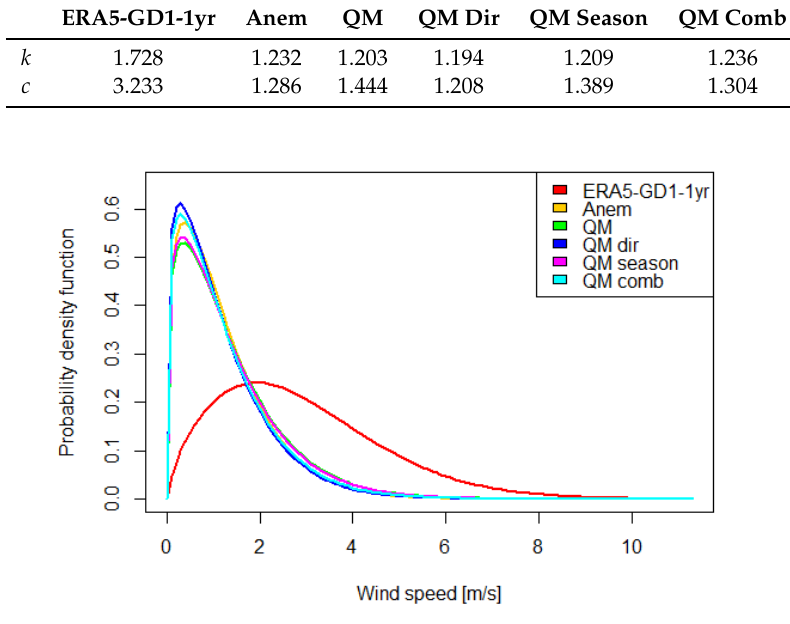
Figure 16. Probability density functions of the Weibull distributions of various wind speed series covering a 1-year period, using only certain wind